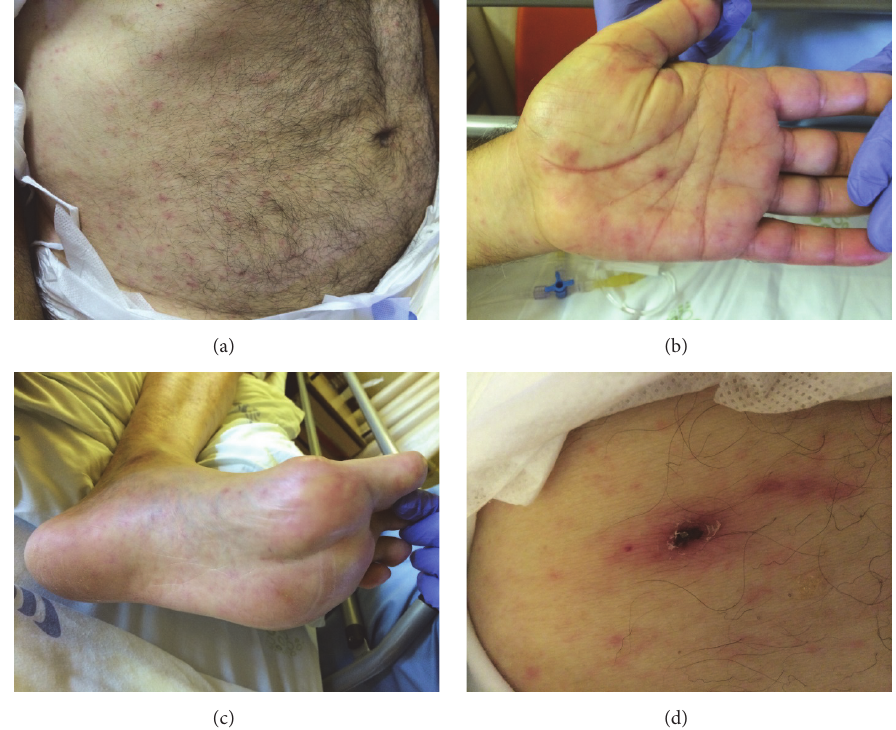
Figure 1: Maculopapular disseminated rash (a), including the palms of the hands (b) and the soles of the feet (c) and a dark brown inoculation eschar ( tache noir ) in the left inguinal region